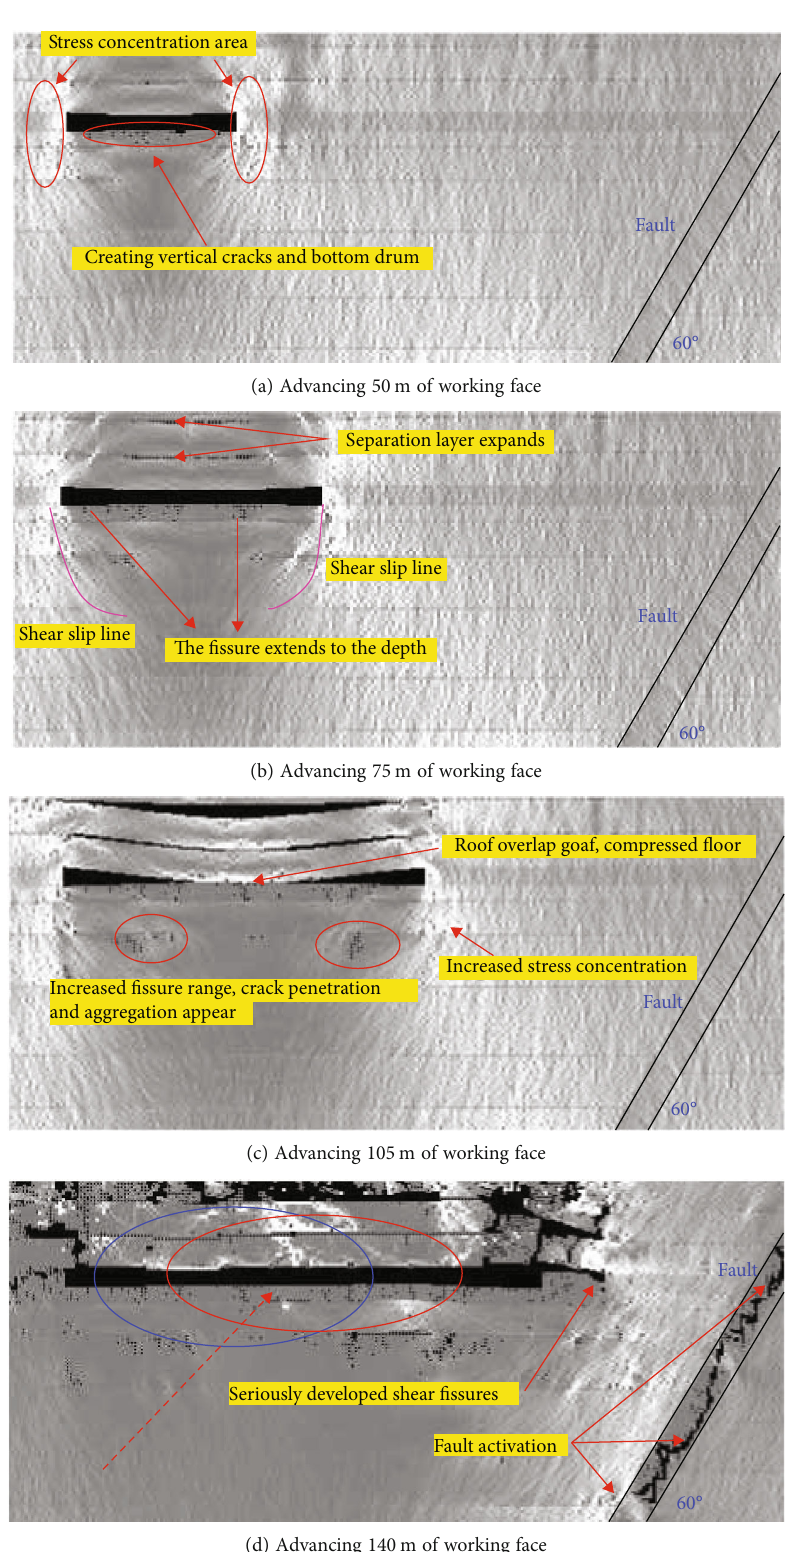
Figure 8: Mining crack evolution process (60 ° , project